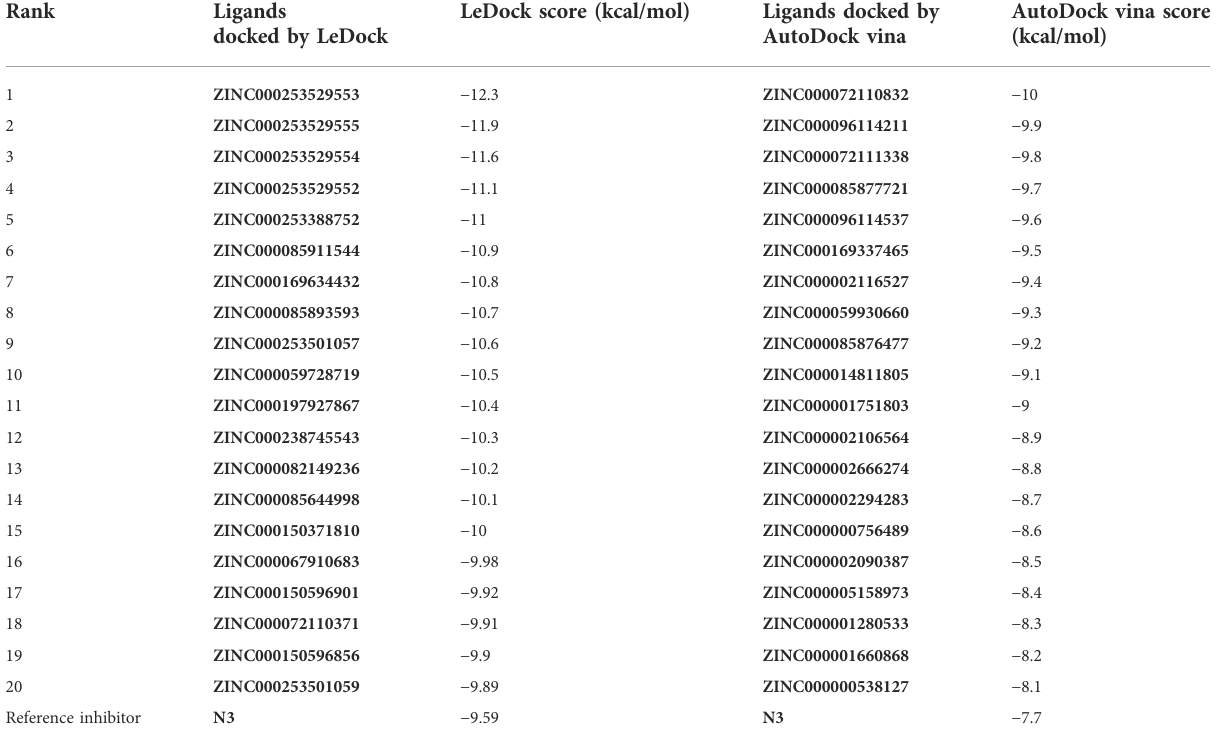
TABLE 1 Top 20 results after 9,614 ligands docked with receptor by LeDock or AutoDock Vina. Rank Ligands LeDock score (kcal/mol) Ligands docked by AutoDock vina score docked by LeDock AutoDock vina